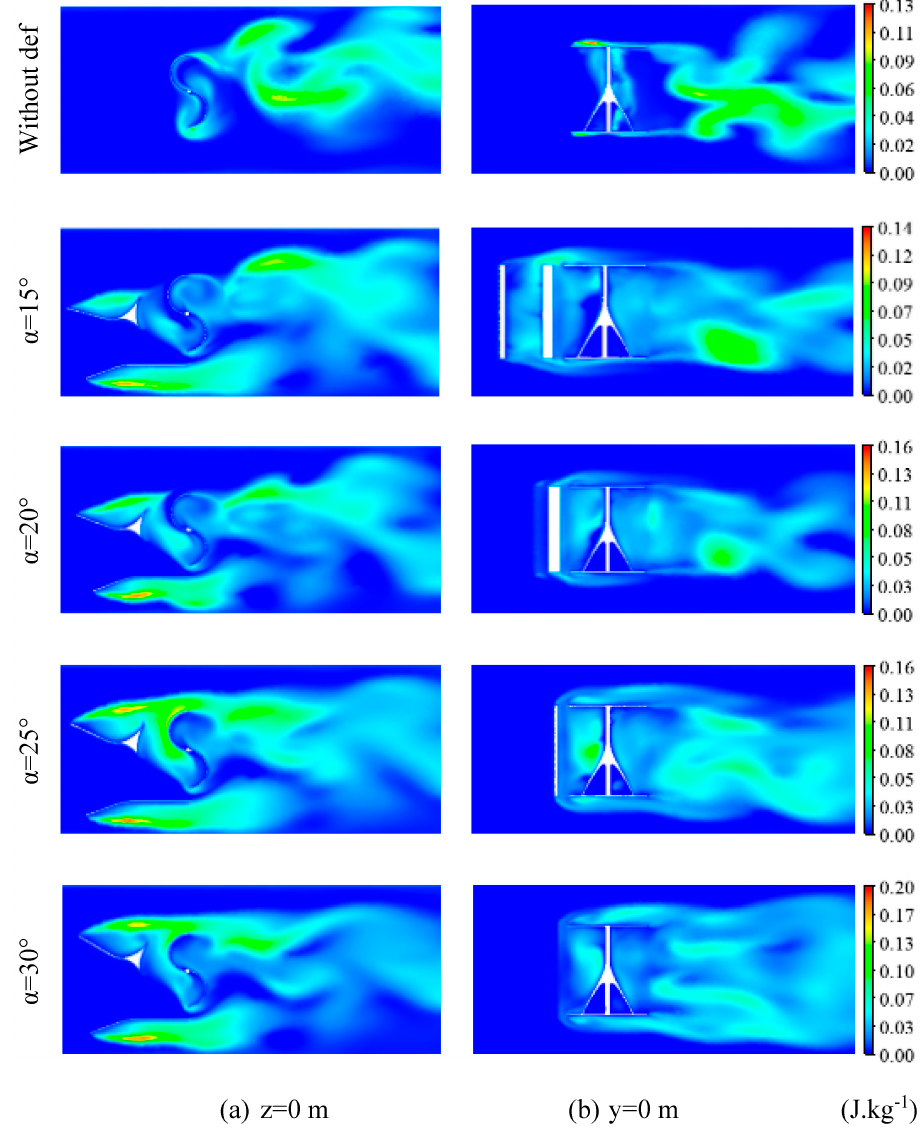
Figure 15. Turbulent kinetic energy distribution for different deflection angles. Upstream the rotor, the turbulent kinetic energy is almost negligible. It increases slightly around the rotor and seems more remarkable at the attack point of both the ad- vancing and the returning blade for the proposed configurations (Figure 15a). This in- crement is likely to be related to the energy produced from the lift force while the turbine rotates. Comparing the distribution of the turbulent kinetic energy for the proposed de- flector systems, it is noticed that the increase in the deflection angle leads to an im-